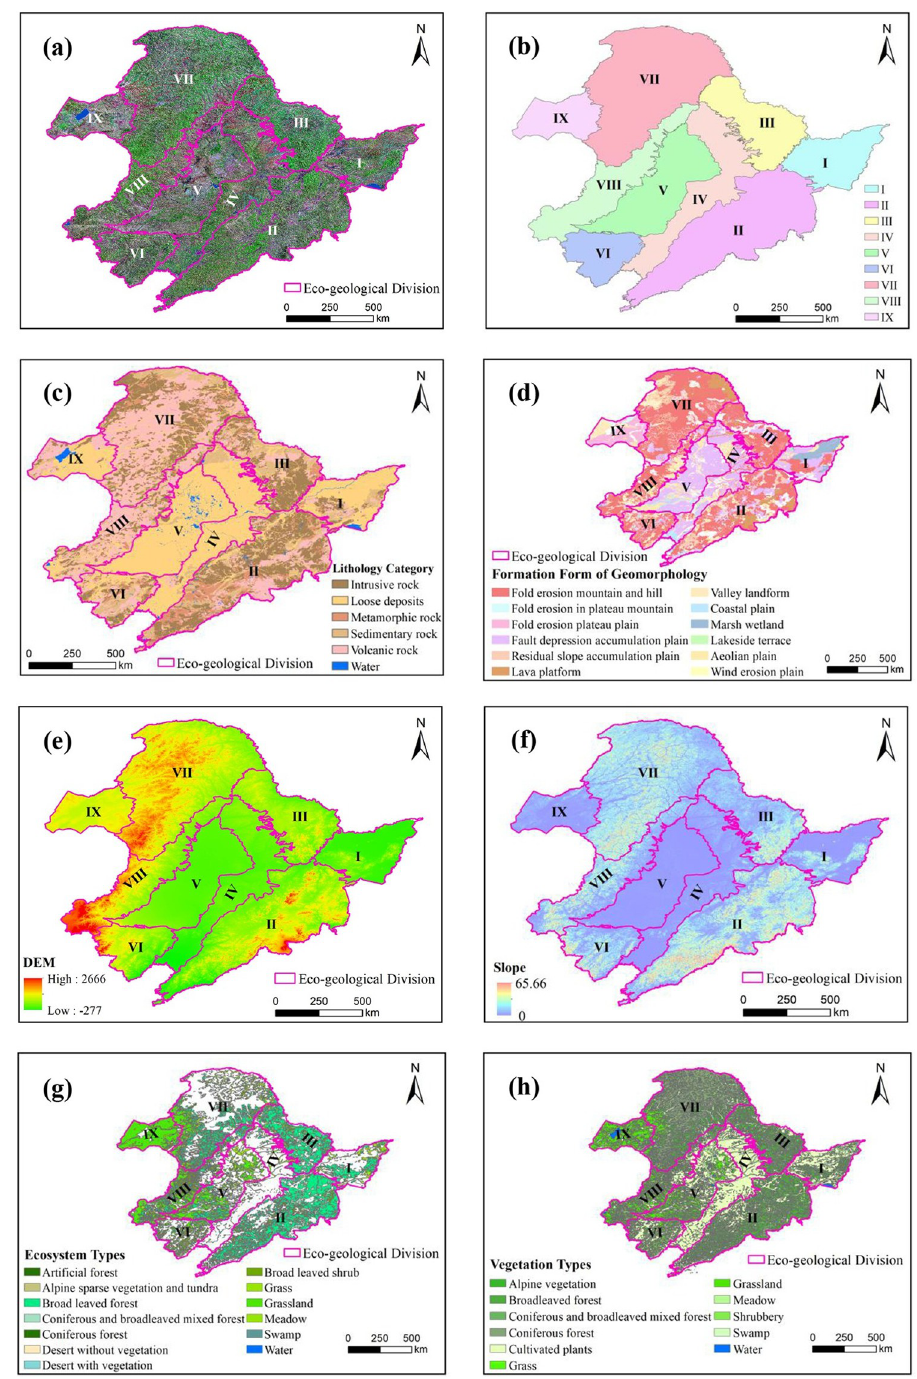
Fig 2. Eco–geological division of Northeast China. (a) Remote sensing image and divisions; (b) Nine eco–geological divisions; (c) Lithology and divisions; (d) Landform and divisions; (e) Altitude and divisions; (f) Slope and divisions; (g) Ecosystem and divisions; (h) Vegetation type and divisions. Digital elevation model and Landsat–8 images were provided by USGS EROS (Earth Resources Observatory and Science (EROS) Center) (http://eros.usgs.gov/#). All maps were further processed using ArcGIS 10.4